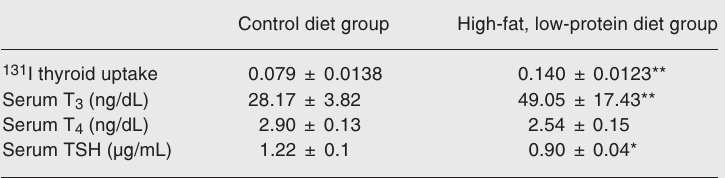
Figure 4. Body weight from day 15 of gestation to parturition (A) and from pup birth to weaning (B) of dams fed a normal (filled ** squares) and high-fat, low-pro- tein diet (open squares) through- out this period. Data are re- ported as the means ± SEM for 8 animals per group. A , F = 37.6 for diet and 55.4 for time (P < 0.0001, two-way ANOVA; *P < 0.05, **P < 0.01 and + P < 0.001, Bonferroni post-test). B , F = 111.5 for diet and 2.6 for time (P < 0.0001, two-way ANOVA; P < 0.05, Bonferroni post-test). The arrow indicates that the signifi- cance occurred during all the period.